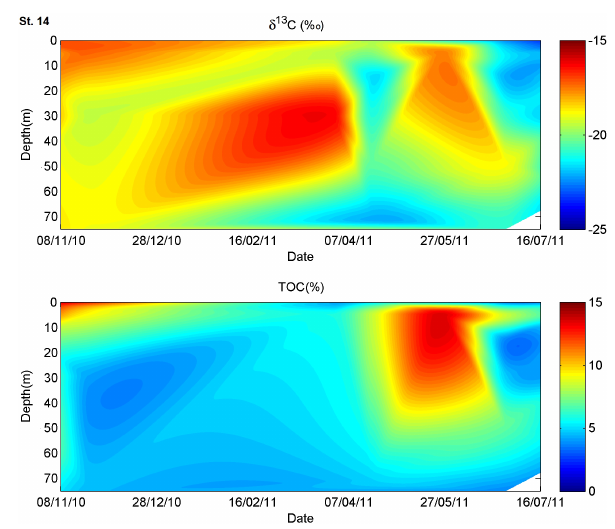
Figure 2. Suspended-particulate-matter composition (TOC% and δ 13 C org ) measured in the water column between October 2010 and October 2011 at station St14, Tongoy Bay, Coquimbo (30 ◦